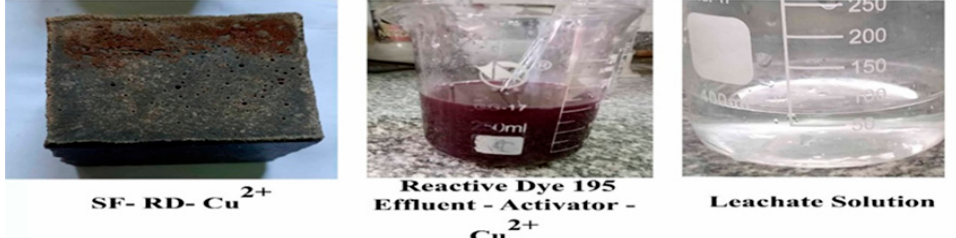
Figure 3. Solidification of a mixture from copper (II) ions and reactive red 195 dyeing bath effluent with slag-FA-based geopolymer mix after 7 days of curing condition.